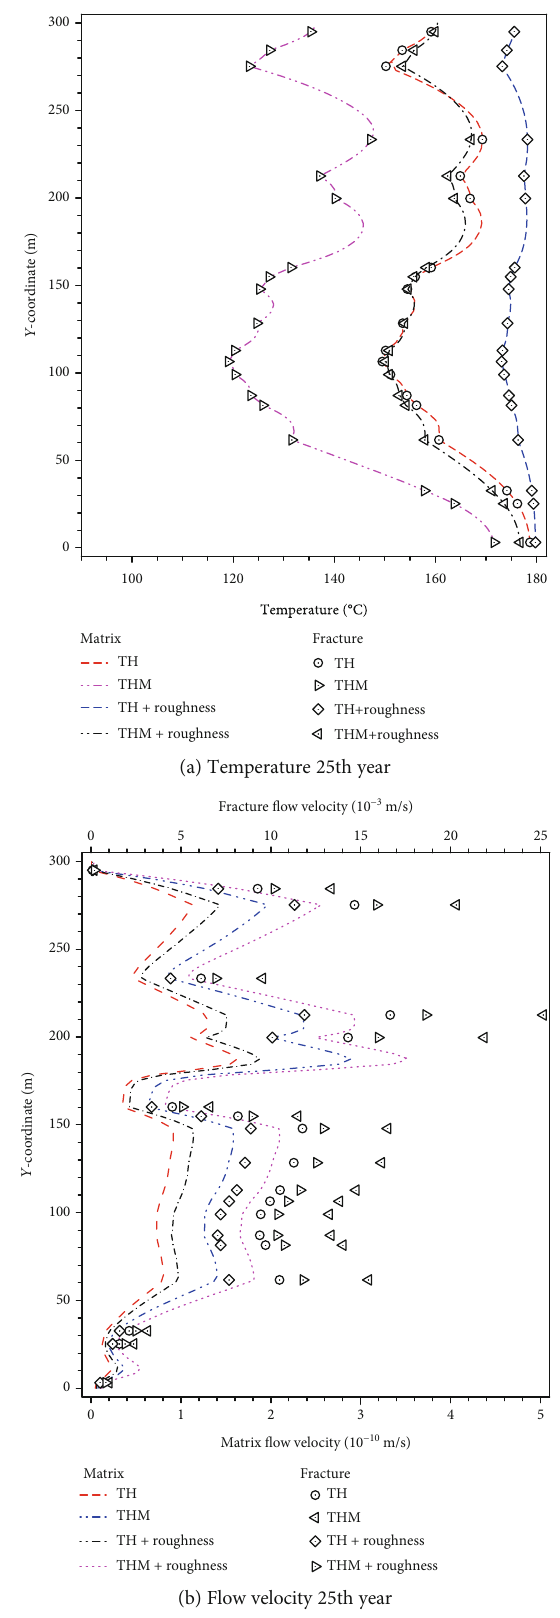
Figure 11: Outlet temperature and fl ow velocity under di ff erent